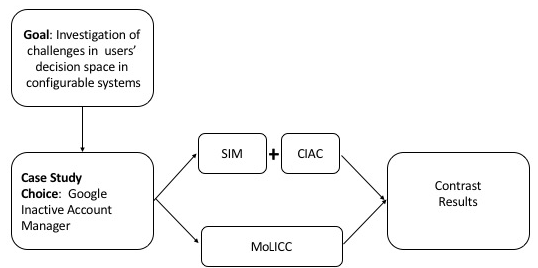
Fig.1 - Methodology